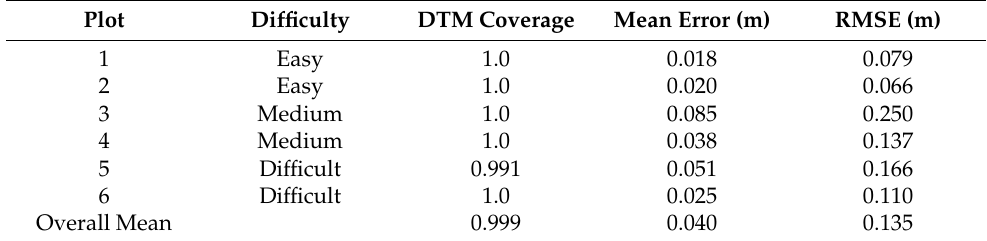
Table 5. Digital Terrain Model evaluation